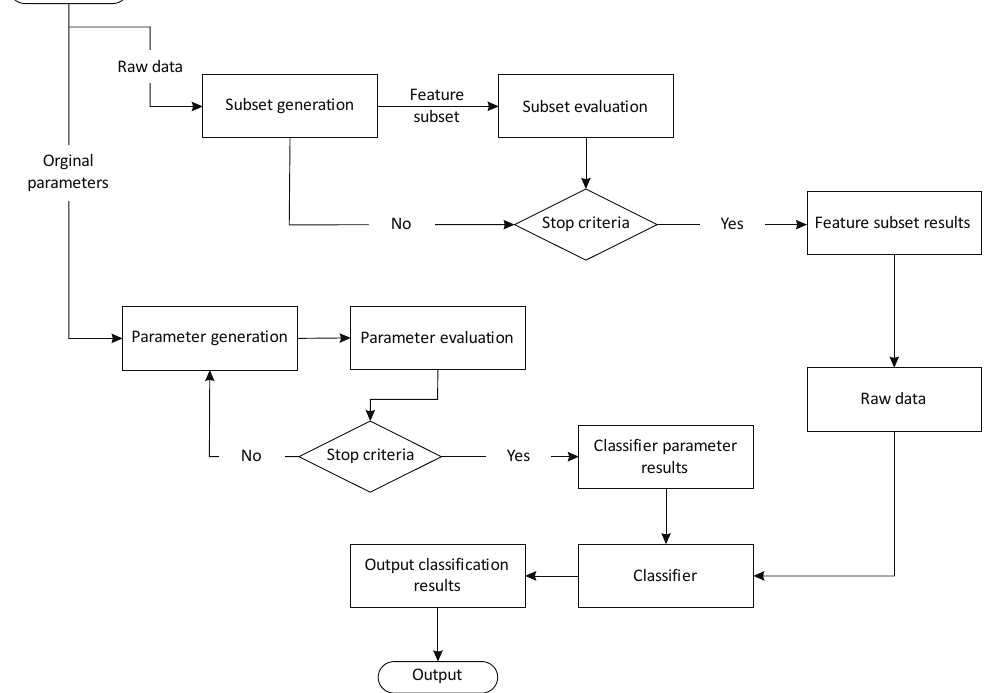
Figure 3. The procedure of proposed combination strategy.